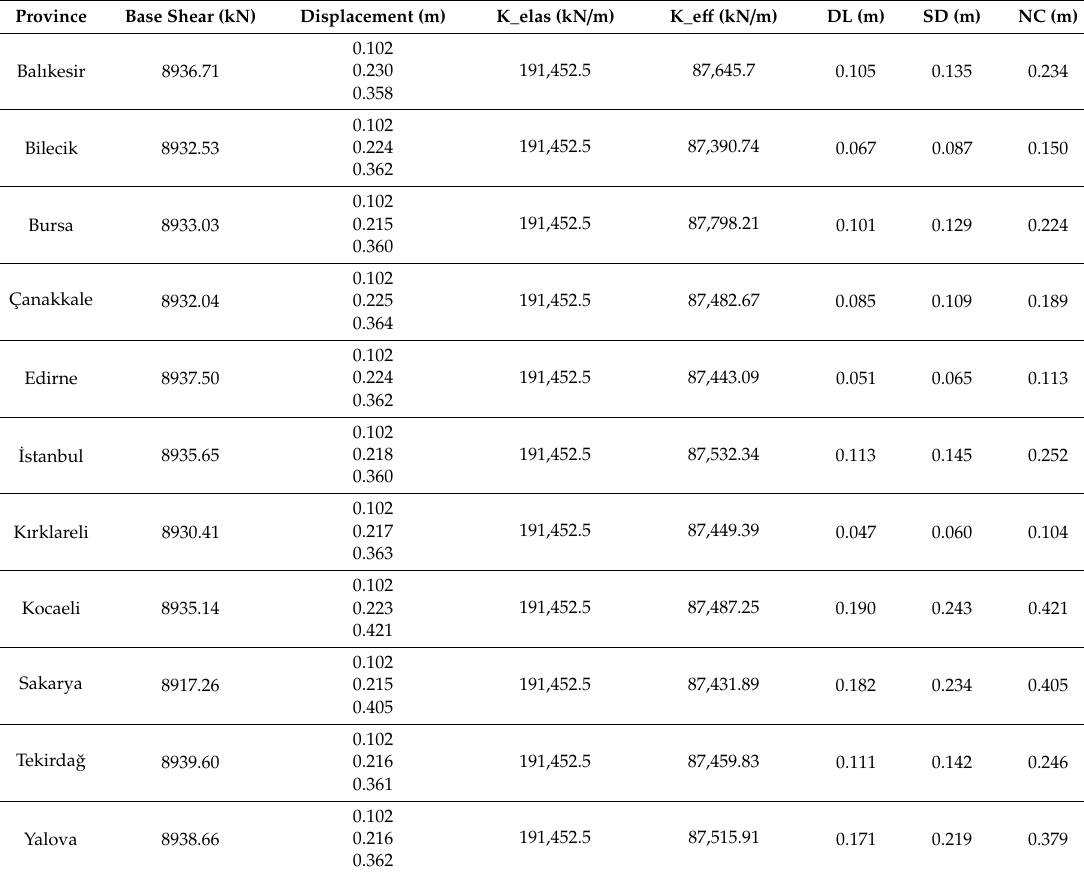
Table 9. Comparison of values obtained in X direction for 6-story building.